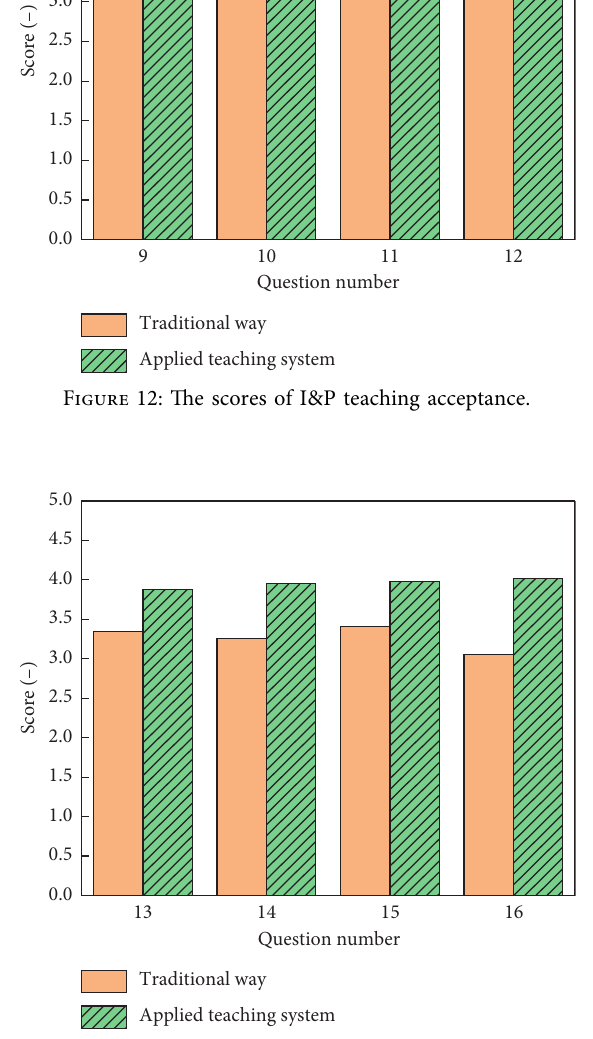
Figure 13: The scores of learning effect of students to the I&P